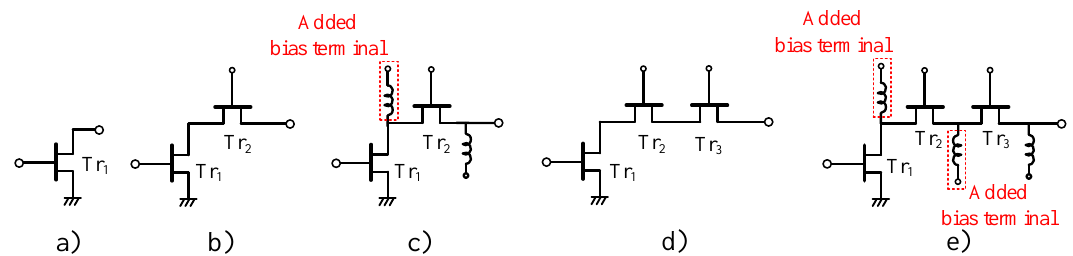
Figure 1. Circuit configurations: ( a ) single-stage; ( b ) conventional cascode; ( c ) independently biased cascode; ( d ) conventional 3-stack; ( e ) independently biased 3-stack.